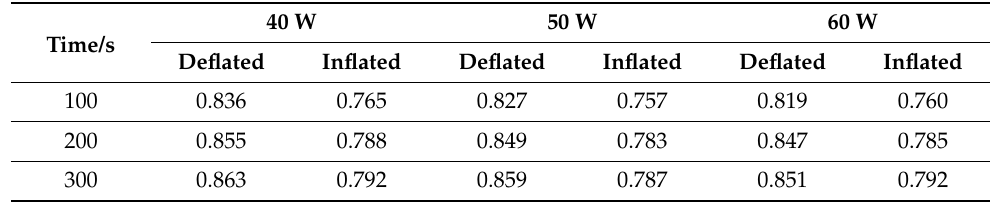
Table 12. Isoperimetric ratio of ablation area. 40 W 50 W 60 W Time/s Deflated Inflated Deflated Inflated Deflated